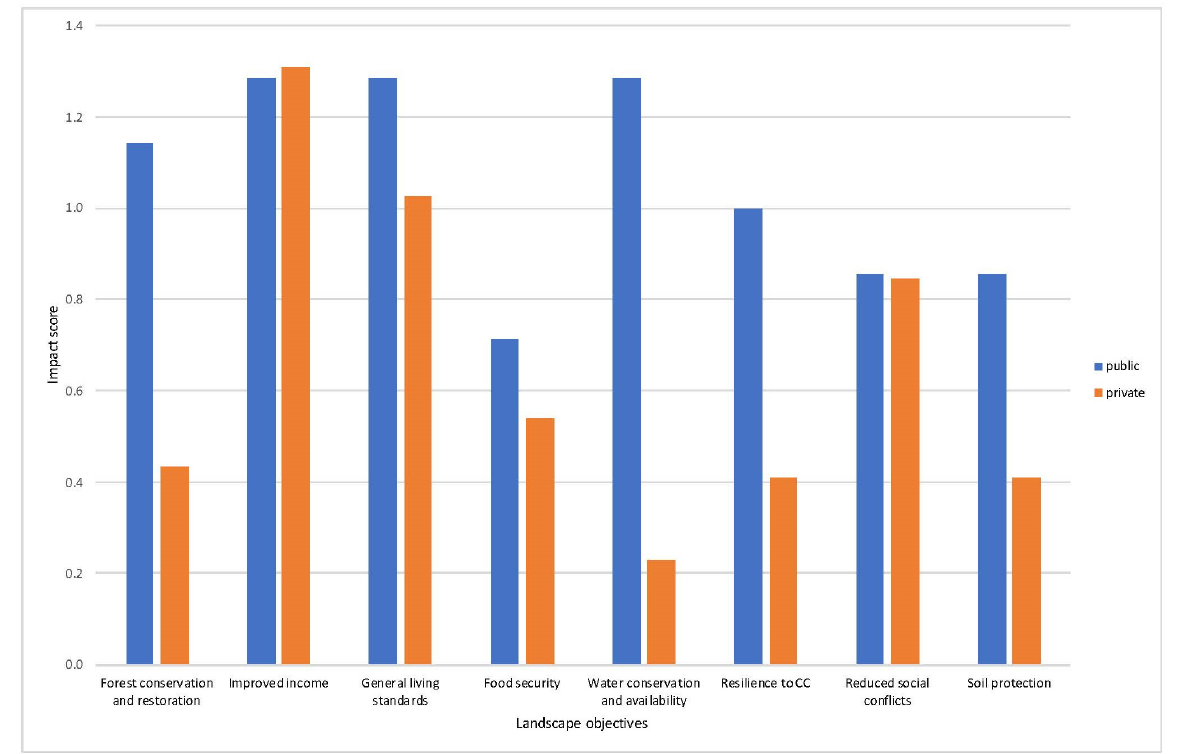
Figure 5. Perceived average impacts per land unit of public and private investments on landscape objectives in the SRB landscape (based on Tropenbos Vietnam forthcoming [19]).